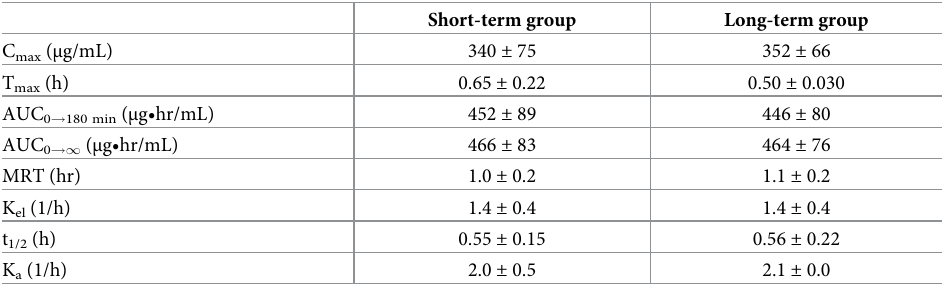
Table 1. Pharmacokinetic parameters of concurrent administration of SVA and